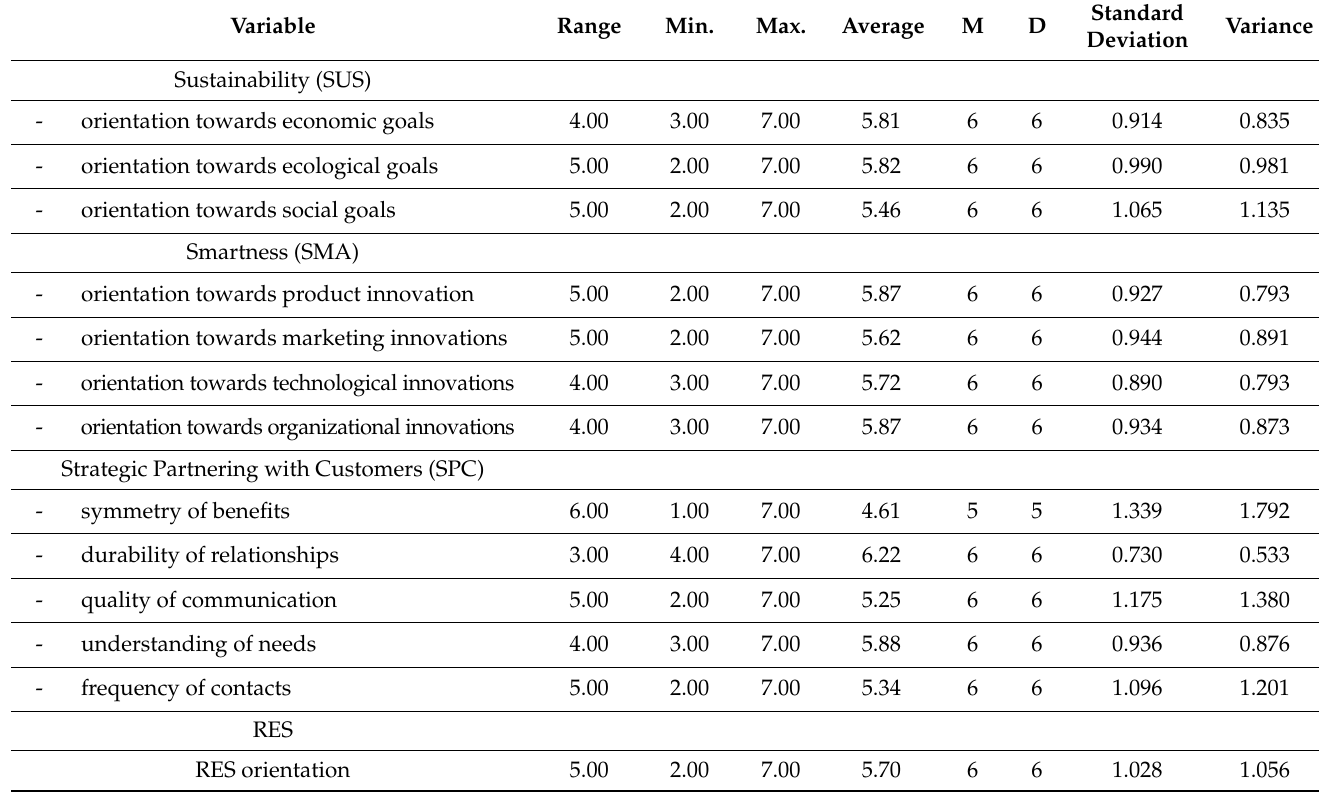
Table 3. Descriptive statistics of the variables examined ( n =